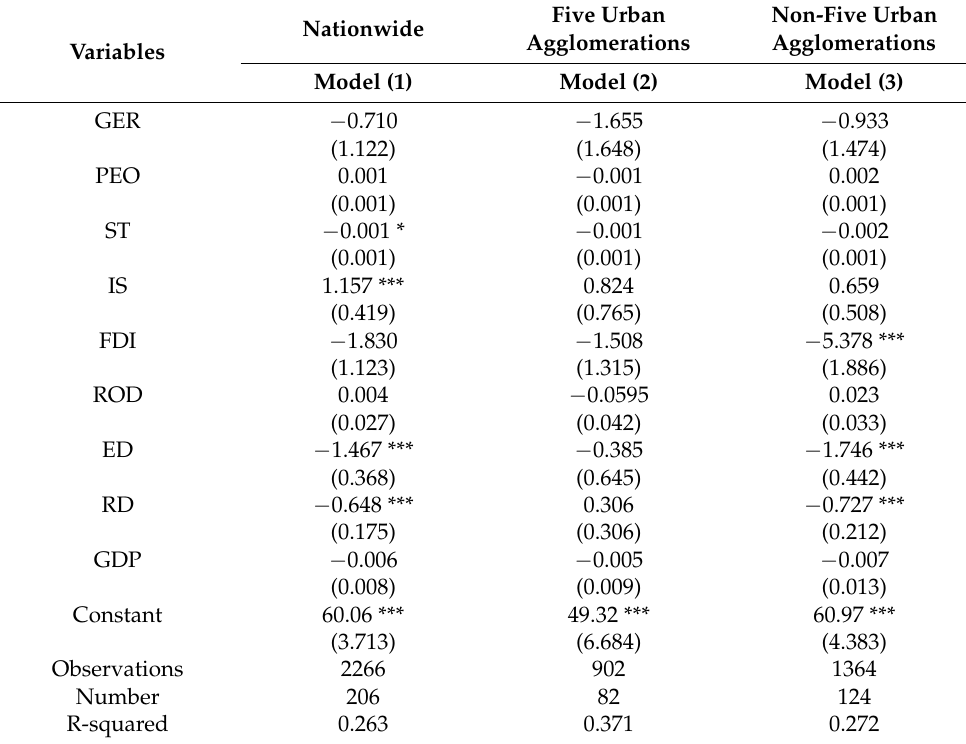
Table 3. Linear models of national, five major urban agglomerations and non-five major urban